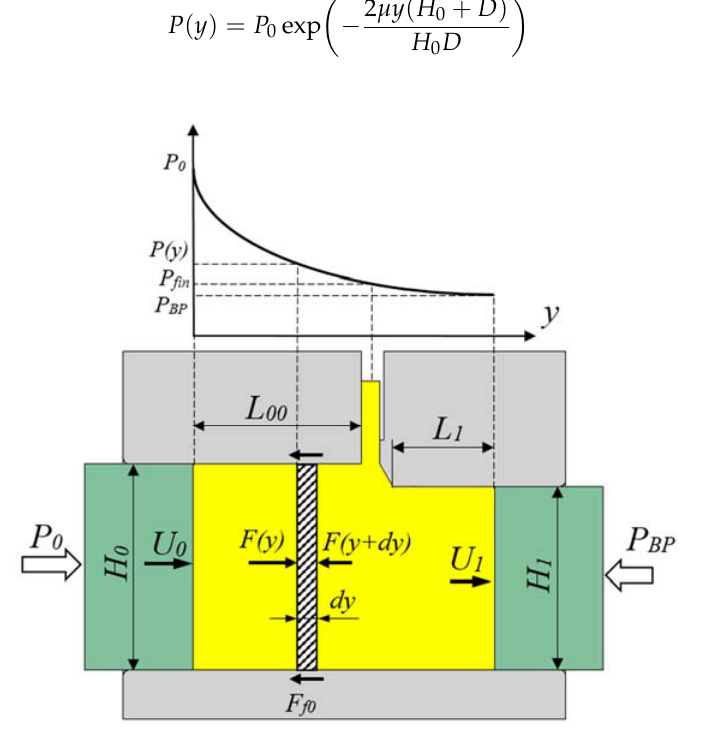
Figure A1. The method of slices schematically showing the stress distribution.